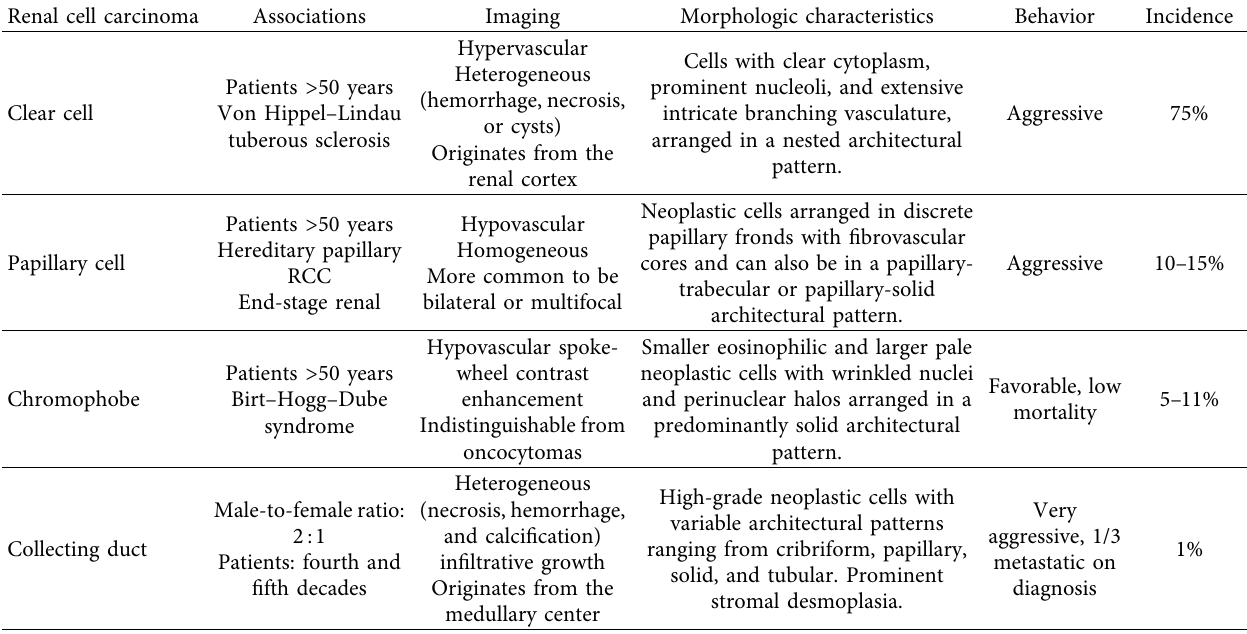
Figure 2: (a) Well-demarcated lesion of small- to intermediate-sized tubules admixed with cystically dilated tubules (solid thick arrows). (b) Tubules and cysts comprising a single epithelial layer of flat to hobnail-shaped cells with abundant, pink cytoplasm and large nuclei with prominent nucleoli (dashed thick arrows). The stroma was fibrotic and paucicellular, while mitotic activity was low to absent. No papillary architecture or epithelial cell clearing was observed. (c) Immunohistochemical stain for CK7 showed patchy reactivity (thin solid arrows) in the lesional areas. (d) CD10 showed strong reactivity. Table 1: Common subtypes of renal cell carcinoma